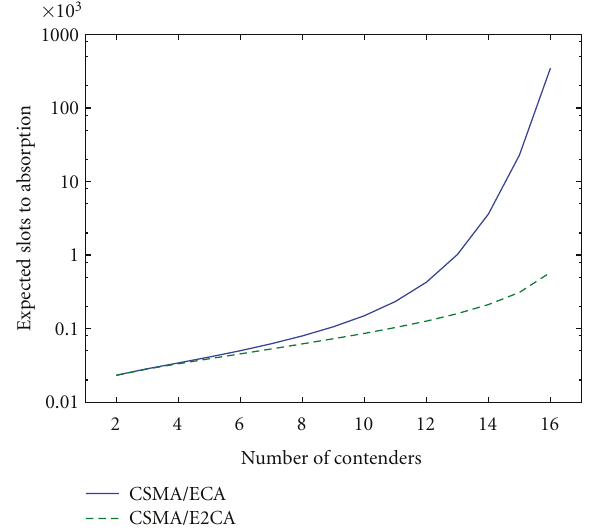
Figure 4: Expected number of slots required to reach collision-free operation in CSMA/ECA and CSMA/E2CA for various numbers of contenders.